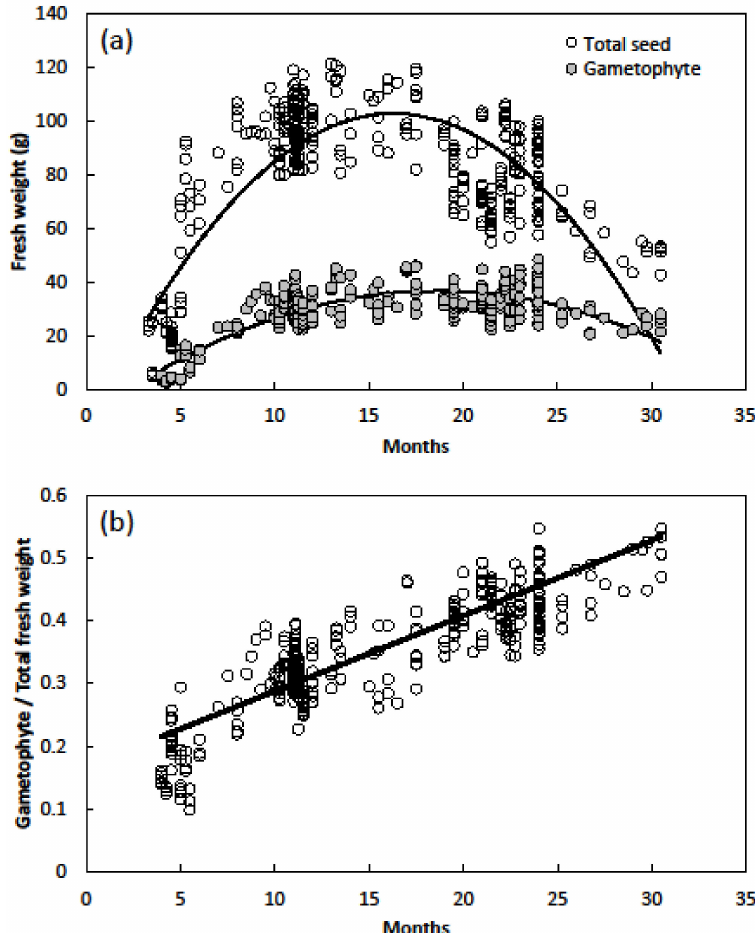
Figure 4. Fresh weight of Cycas micronesica seeds from 3 to 30 months in age. ( a ) Total seed weight, open circles: y = − 16.23 + 14.55x − 0.45x 2 , p ≤ 0.001, r 2 = 0.73, gametophyte weight, shaded circles: y = − 10.72 + 5.09x − 0.14x 2 . p ≤ 0.001, r 2 = 0.66; ( b ) The quotient gametophyte / total seed: y = 0.17 + 0.01x, p ≤ 0.001, r 2 =